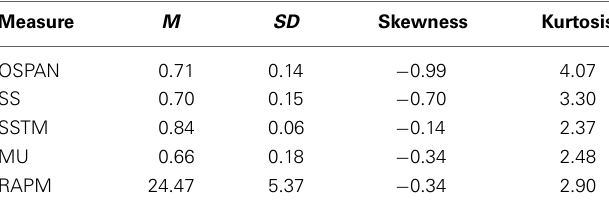
Table 1 | Means, standard deviations, skewness, and kurtosis for the operation span task (OSPAN), sentence span task (SS), spatial short-term memory task (SSTM), memory updating task (MU), and Raven’s Advanced Progressive Matrices (RAPM).